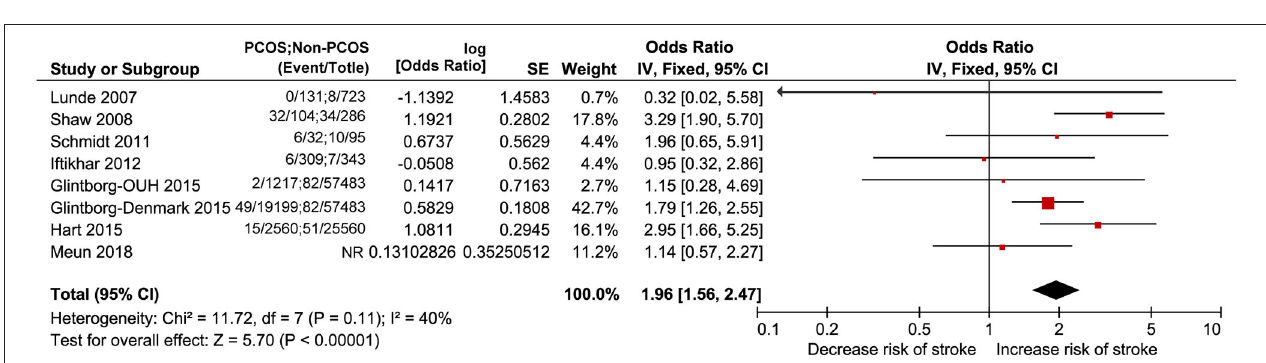
FIGURE 7 | Forest plot comparing PCOS and non-PCOS for